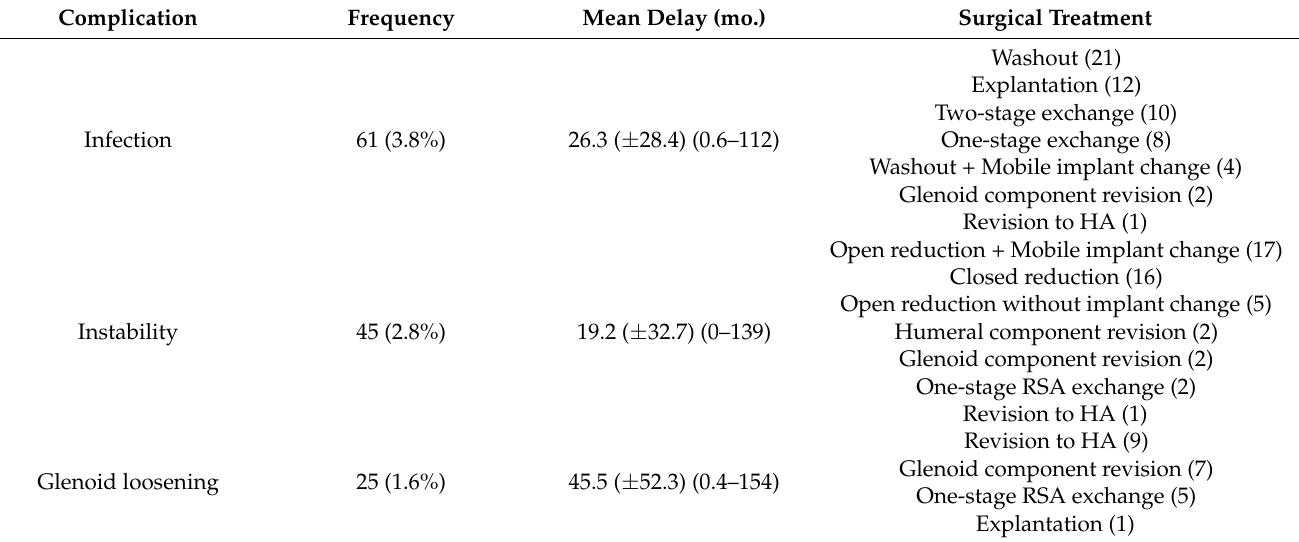
Table 2. Most frequent postoperative complications and their surgical